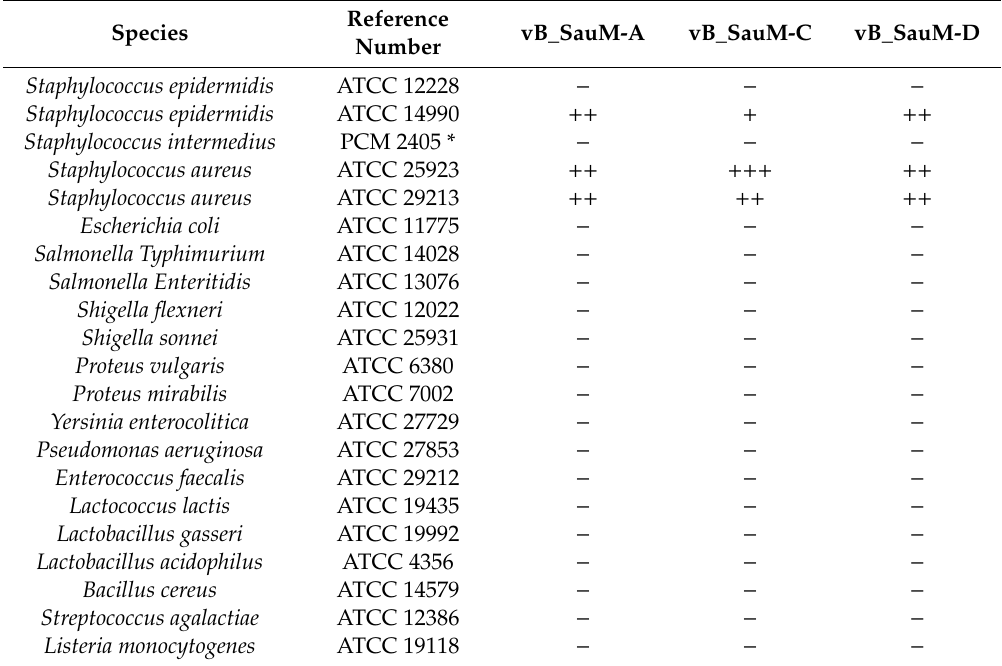
Table 2. Host range of phages vB_SauM-A, vB_SauM-C, vB_SauM-D on di ff erent bacterial species. Species